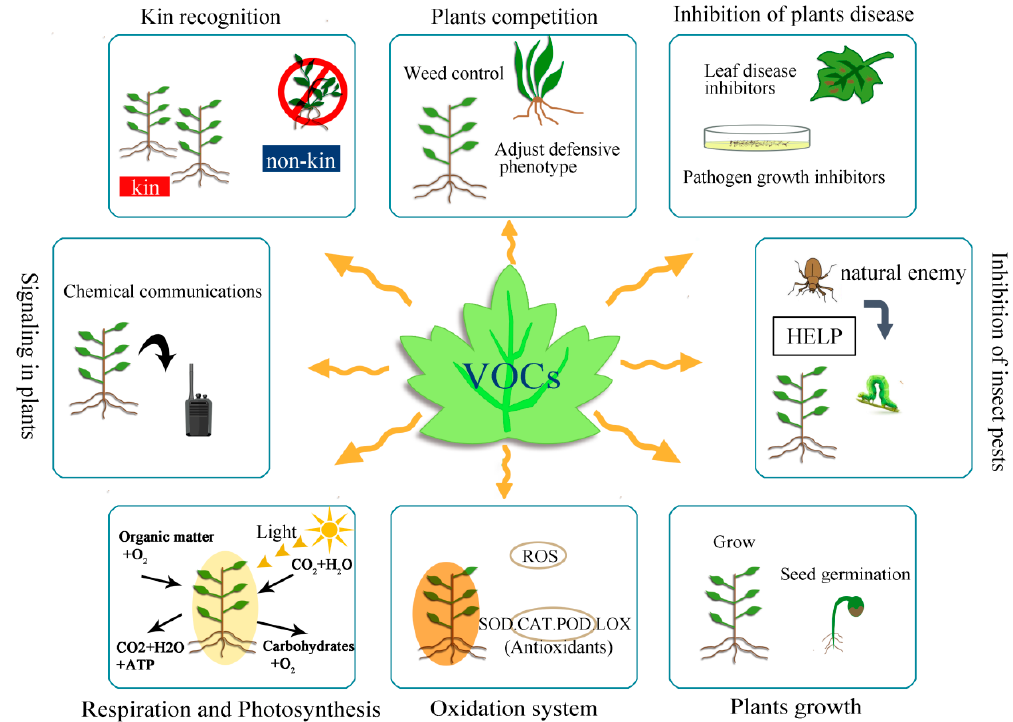
Figure 2. The main allelopathy of plants VOCs. (Note: This figure is widely inspired and adapted from Brilli et al. (2019) [49] ).